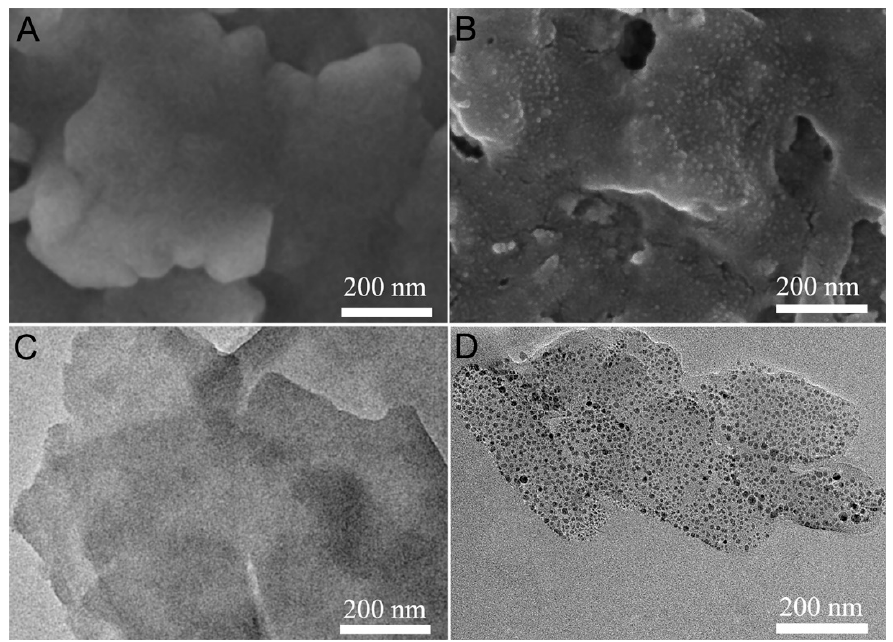
Figure 1. SEM images ( A , B ) and TEM images ( C , D ) of MoS 2 nanoslices ( A , C ) and MoS 2 / Au nanocomposites ( B , D ).